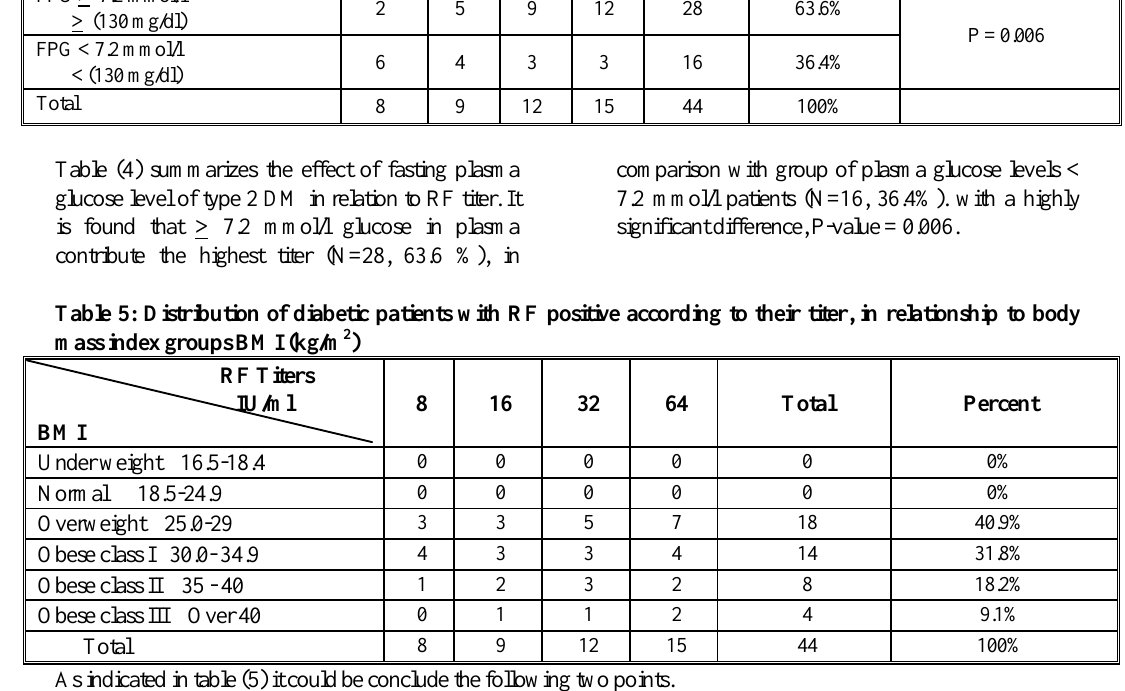
Table 4:Distribution of diabetic patients who have RF positive according to their glycemic control and RF titer. RF titers Glycemic Control level